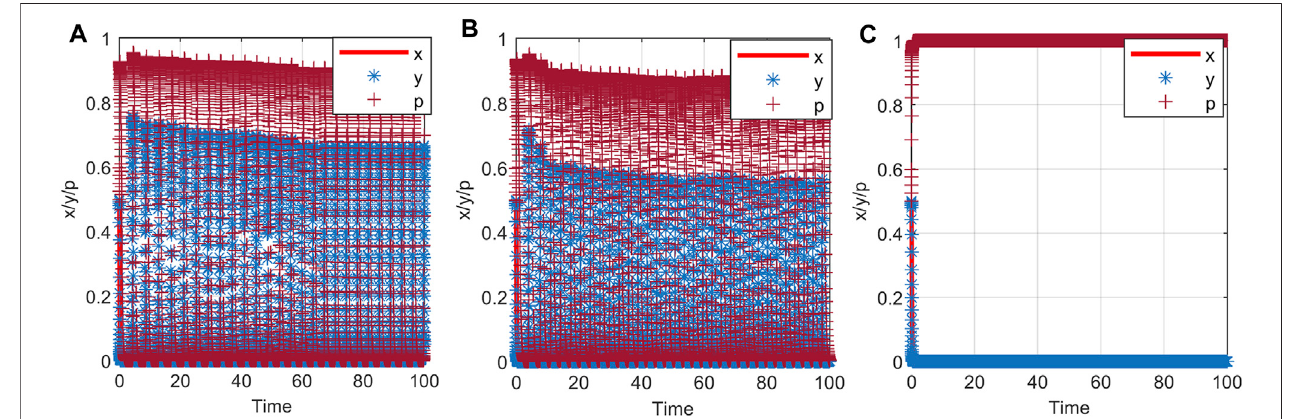
FIGURE 8 | The impact of consumer complaint. (A) when the situation is (0). (B) when the situation is (0.5). (C) when the situation is